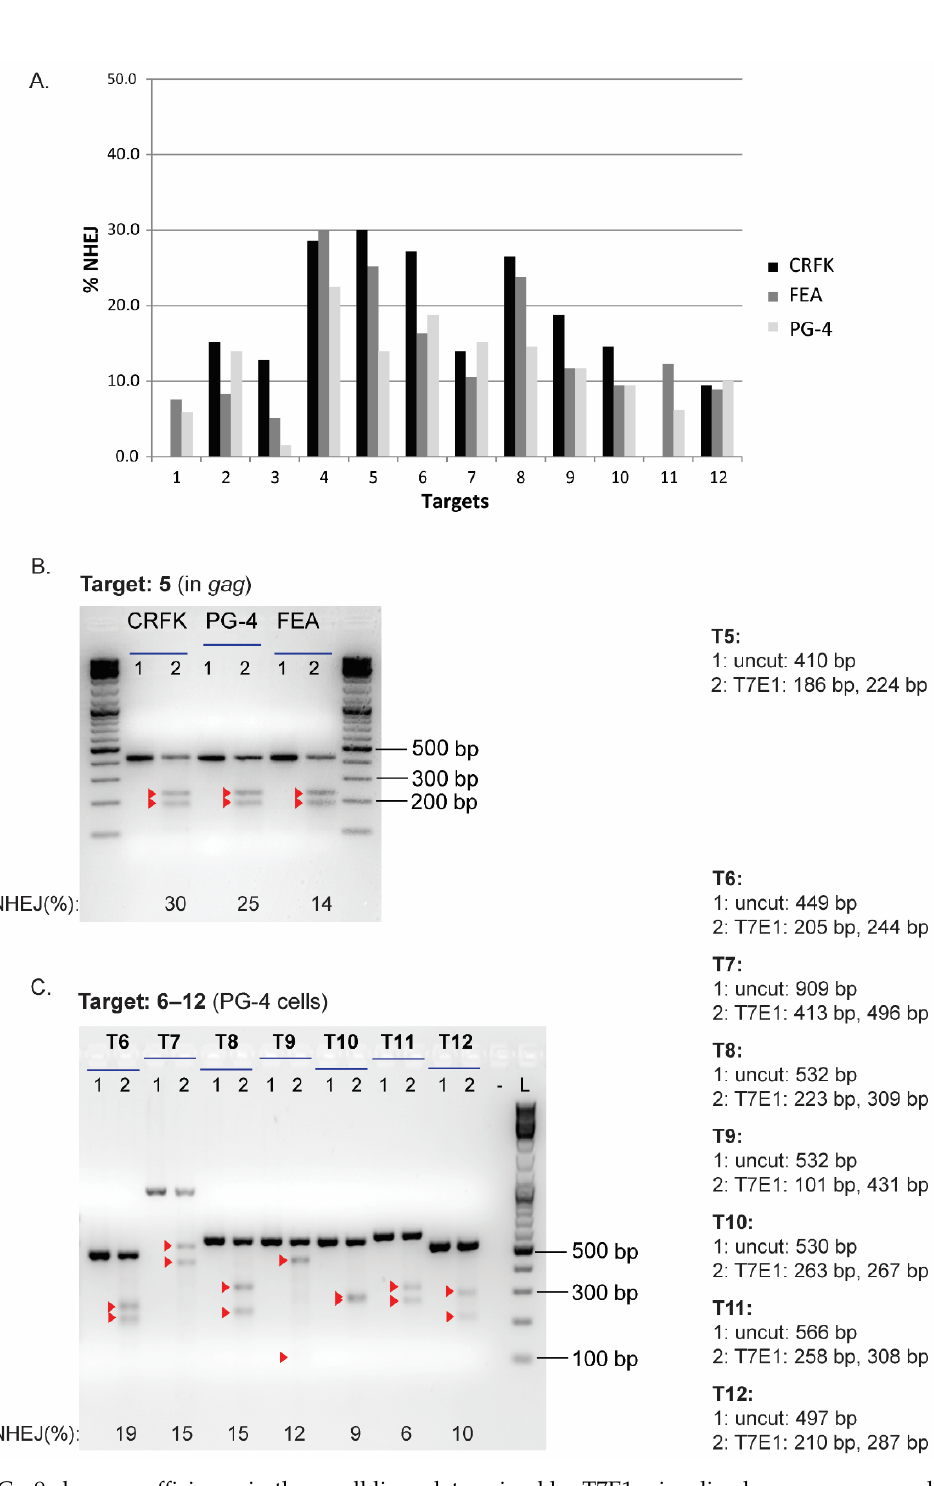
Figure A3. Sa Cas9 cleavage efficiency in three cell lines determined by T7E1, visualized on an agarose gel. T7E1 assay showing percentage of NHEJ at the 12 FeLV target sites after transfection of CRFK, FEA, and PG-4 cells and sorting ( A ). Selected results showing Sa Cas9 cleavage efficiency at the Target 5 in CRFK, PG-4, and FEA cells ( B ) and Targets 6–12 in PG-4 cells ( C ) visualized after T7E1 cleavage on agarose gels. Red triangles indicate cleaved fragments.